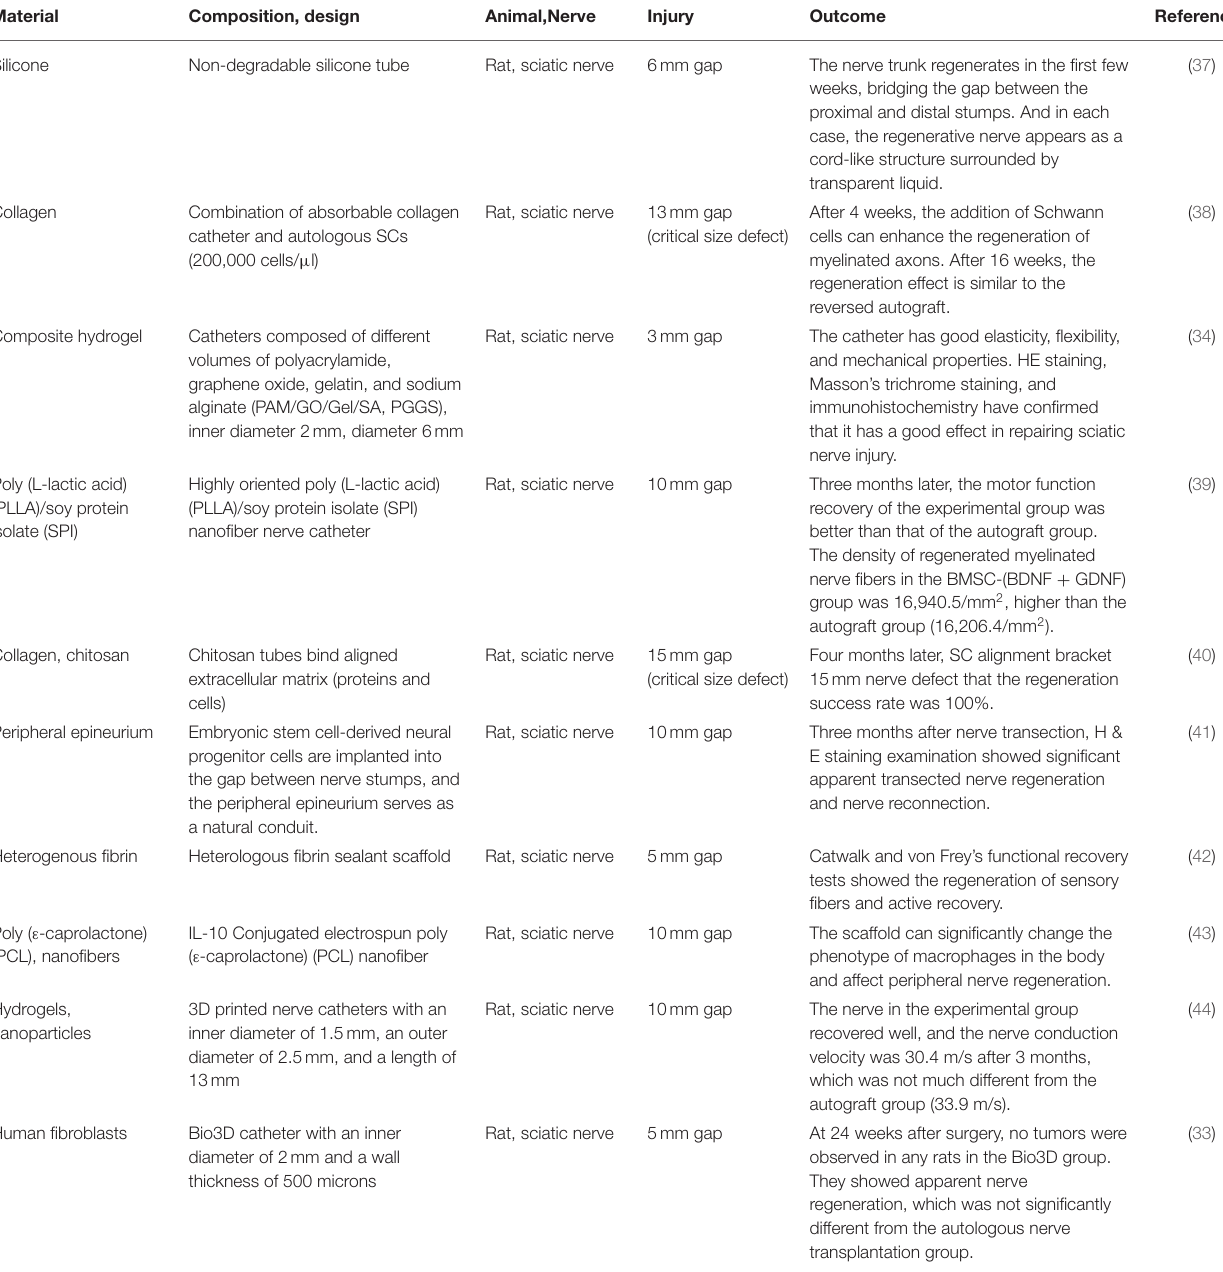
TABLE 3 | Material, design, and applications of currently available nerve guidance conduits